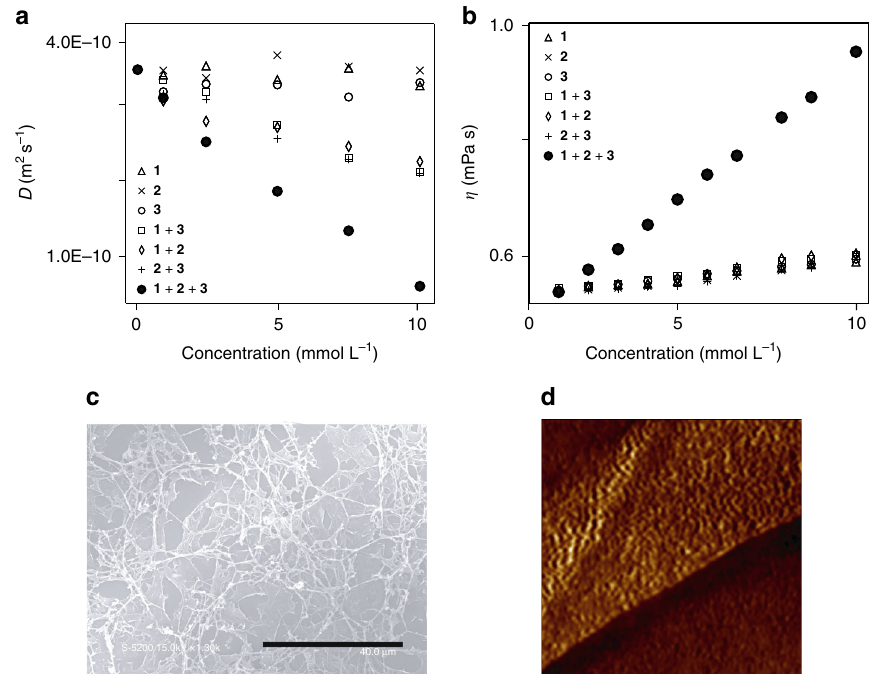
Fig. 3 Properties and morphologies of supramolecular terpolymer [ 1 – 2 – 3 ] n . a Diffusion coef fi cients ( D ) in chloroform- d 1 . b Viscosities ( η ) in chloroform. c SEM image of supramolecular terpolymer. The scale bar denotes 40 μ m. d AFM image (200 nm × 200 nm) of a spin-coated fi